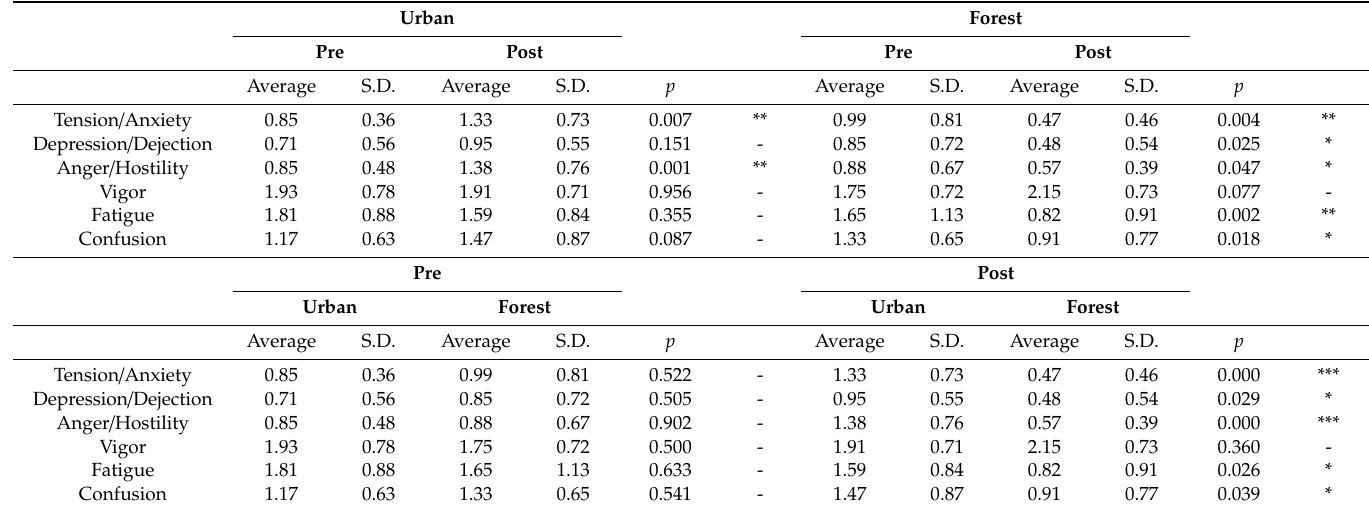
Table 4. Results of multiple comparisons of POMS scores for urban versus forest environments, as well as before and after environmental exposure. Urban Forest Pre Post Pre Post Average S.D. Average S.D. p Average S.D. Tension /